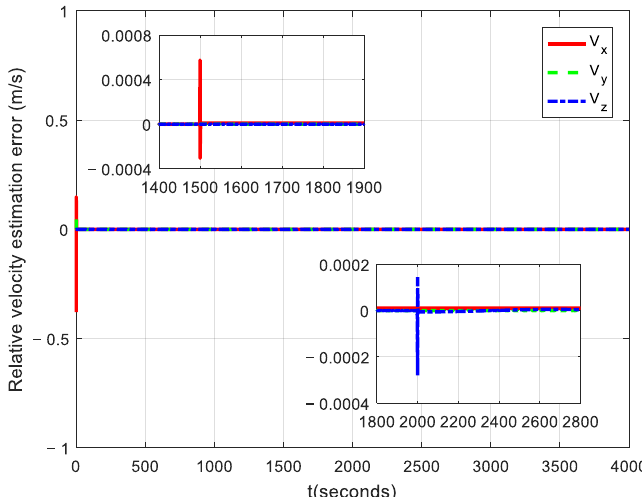
Figure 4. Estimation error of relative position using the designed ILO.